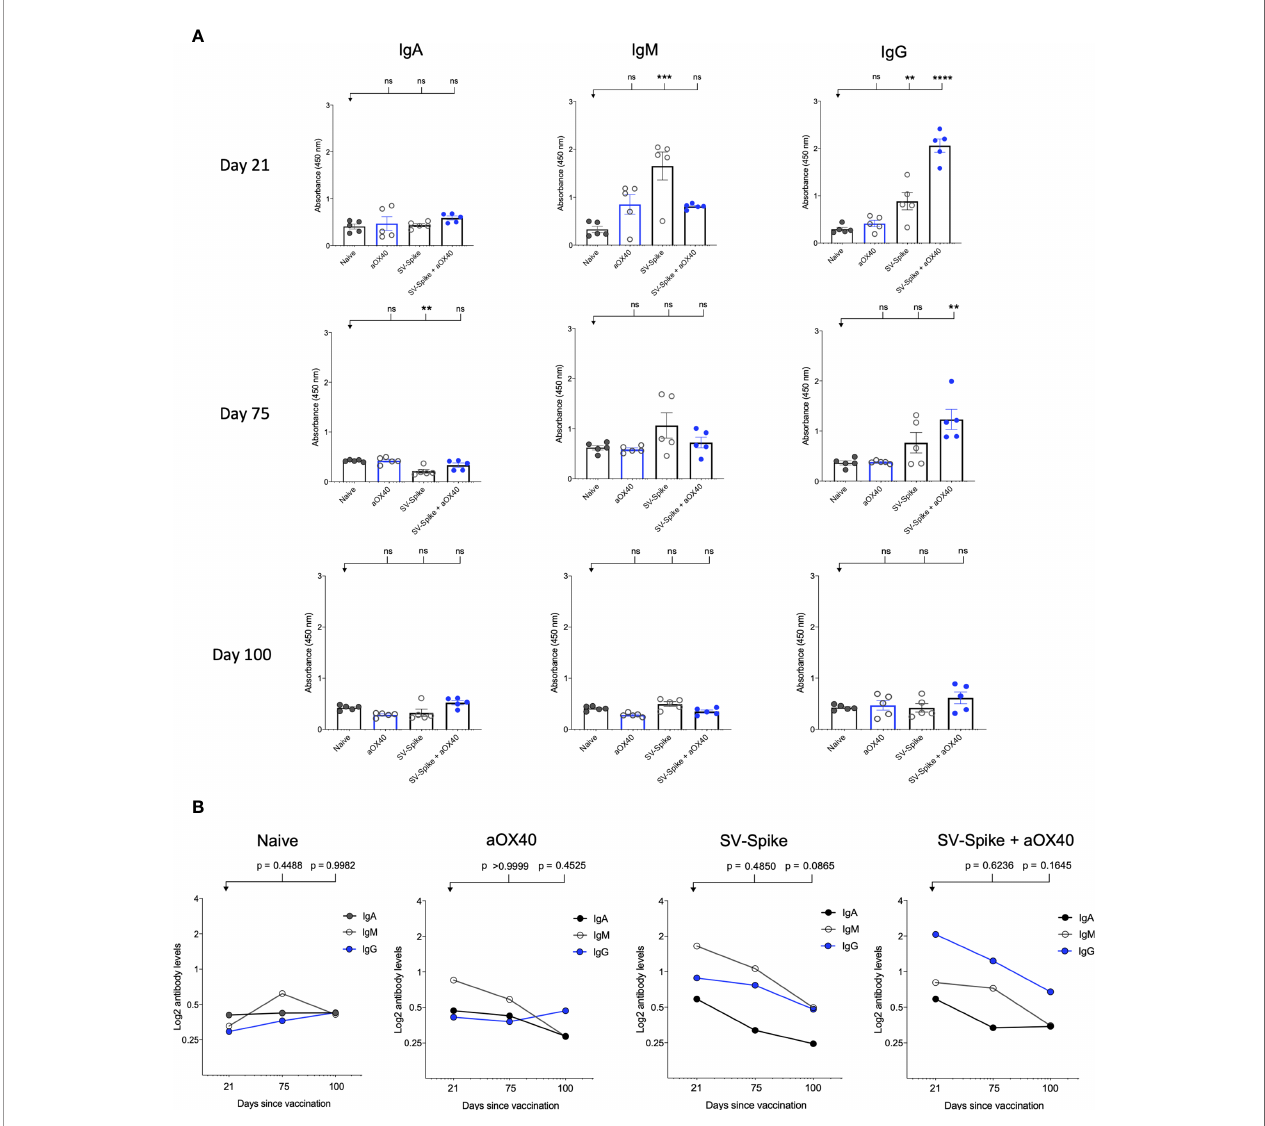
FIGURE 2 | SARS-CoV-2 spike speci fi c antibodies induced by Sindbis vector. Characterization of serum IgA, IgM, and IgG in C57BL/6J mice vaccinated with SV.Spike at days 21, 75, and 100 post-immunization. (A) The levels of Spike-speci fi c IgA, IgM, and IgG isotypes in sera (diluted 1:100) of immunized mice at different time windows. P values were calculated by one-way ANOVA with the Bonferroni correction in Graphpad Prism. n.s. > 0.05; **P<0.01; ***P < 0.001; ****P<0.0001. (B) The kinetics of Spike-speci fi c IgA, IgM, and IgG isotypes in sera of immunized mice at different time windows. Mean comparison between time points and isotypes and relative P values were determined by two-way ANOVA with the Bonferroni correction in GraphPad Prism. The data presented are the mean of three technical replicates. The median values of (A) OD450 or (B) calculated log2 antibody levels were plotted for each isotype of three antibodies. Log2-scale in (B) was used to better represent the proportional relation between antibody titers and sera reciprocal dilution. The data presented are the mean of fi ve biological replicates with two technical